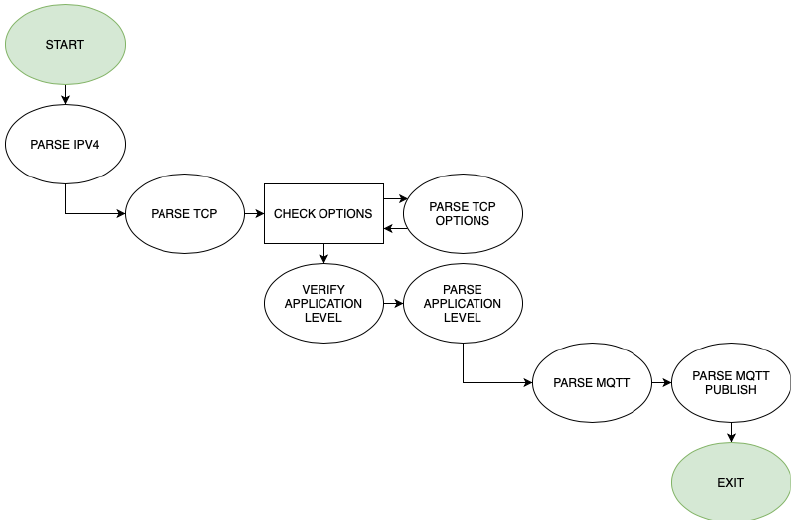
Figure 5. Flux diagram for the parser phase.